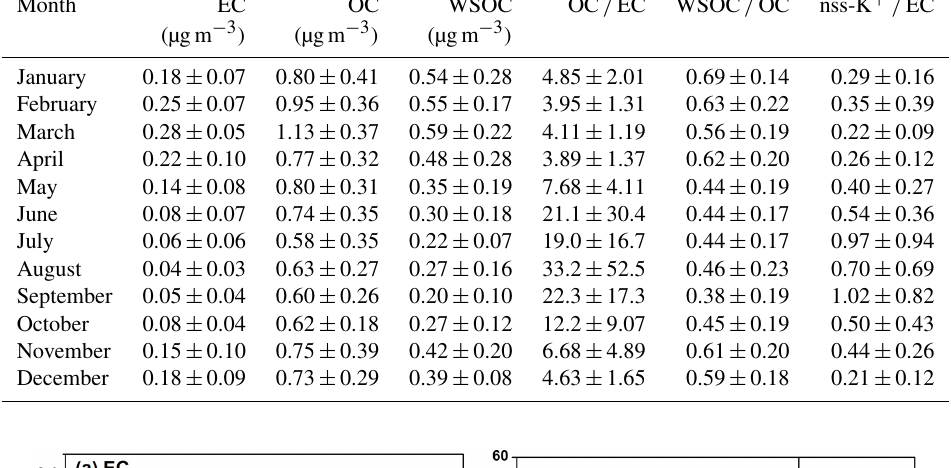
Table 1. Monthly mean ( ± standard deviation) values of EC, OC, WSOC concentrations, and their ratios during 2001–2012 over the western North Pacific.